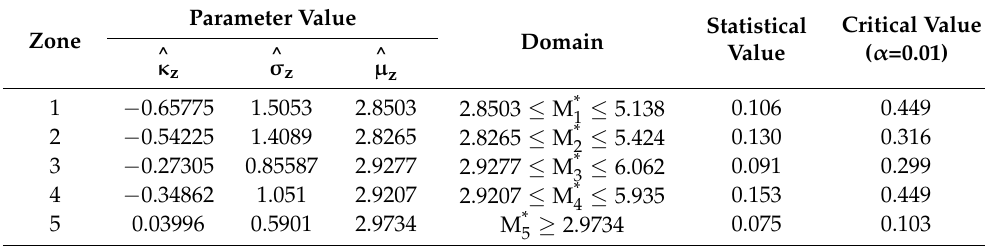
Table 9. The result of the parameter estimation and the KS test based on Cluster Type